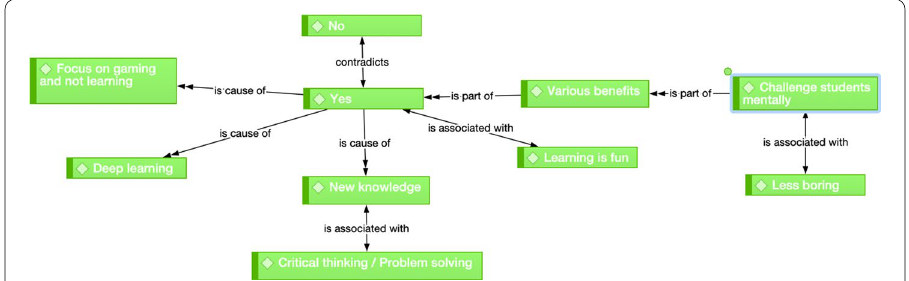
Fig. 5 Game learning network